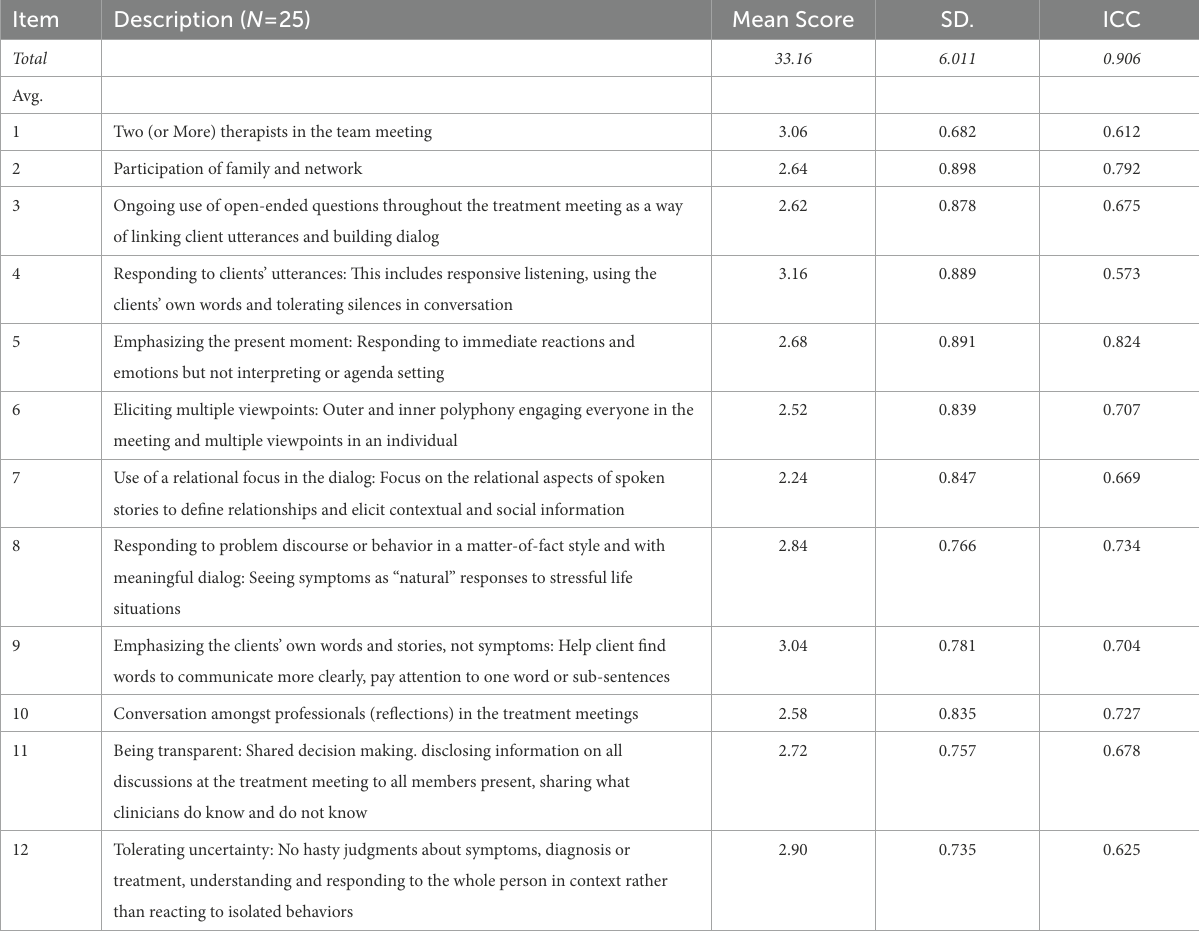
TABLE 2 Inter-rater reliability and adherence